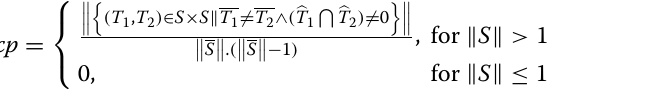
Not‑improved Improved